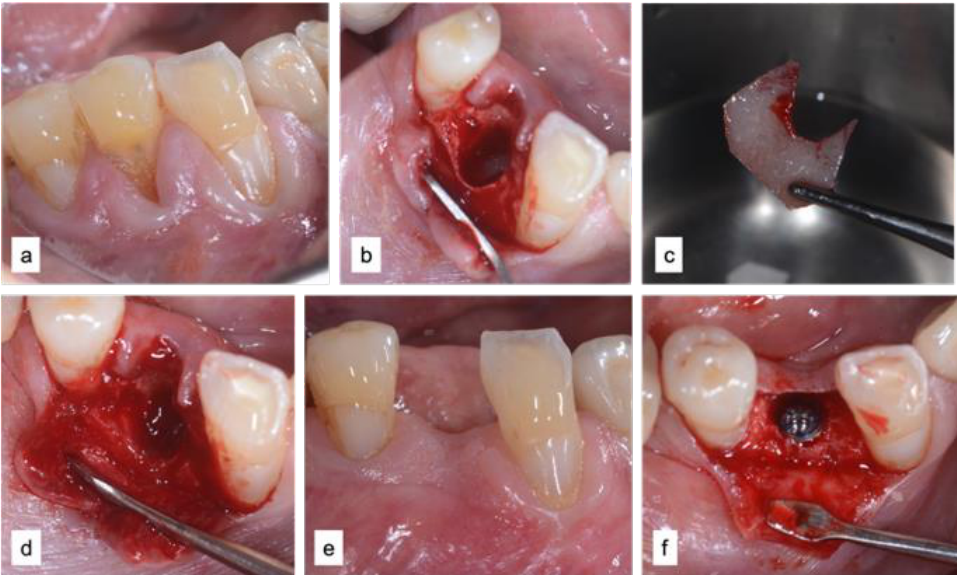
Figure 3. Patient 3. ( a ) Preoperative image of soft tissue recession. ( b ) Thin vestibular bone was exposed. Cortical membrane ( c ) shaped and ( d ) glued. ( e ) Soft tissue healing at 4 months. ( f ) Bone healing and implant placement at 4 months.